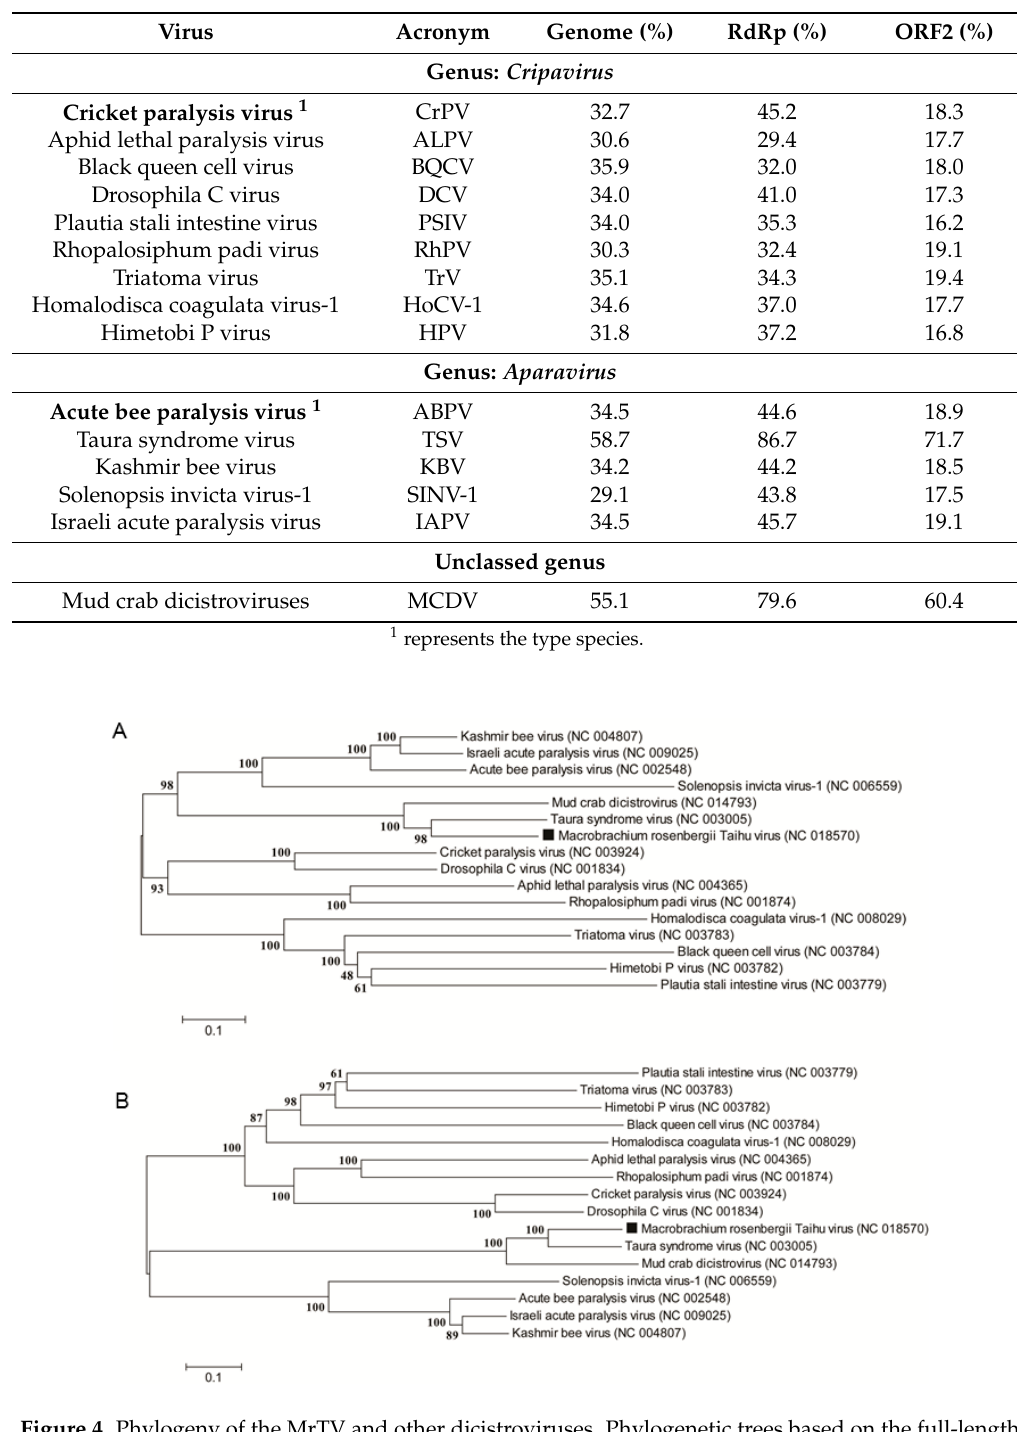
Figure 4. Phylogeny of the MrTV and other dicistroviruses. Phylogenetic trees based on the full-length genomic sequences ( A ) and the deduced amino acid sequences of the capsid protein ( B ) were constructed using the neighbor-joining method with 1000 bootstrap replicates under the parameter of complete deletion and poisson model using MEGA 6.0. The numbers at the branch nodes represent the bootstrap confidence levels of the 1000 bootstrap replications obtained. Bar, 0.1 amino acid substitutions per site. The black aquares indicate MrTV.